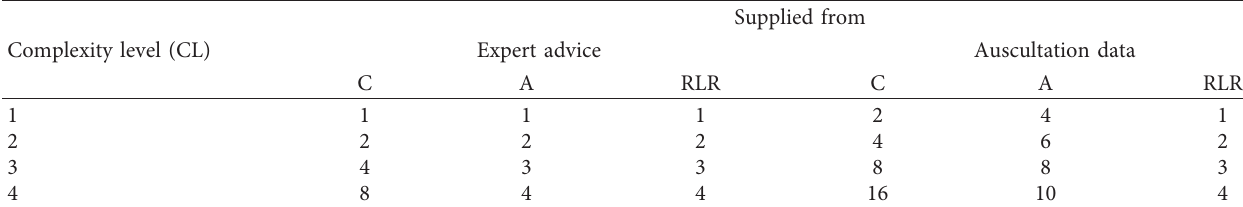
Table 14: Correspondence between complexity level (CL), cost (C), accuracy level (A), and level of robustness loss risk (RLR) for input